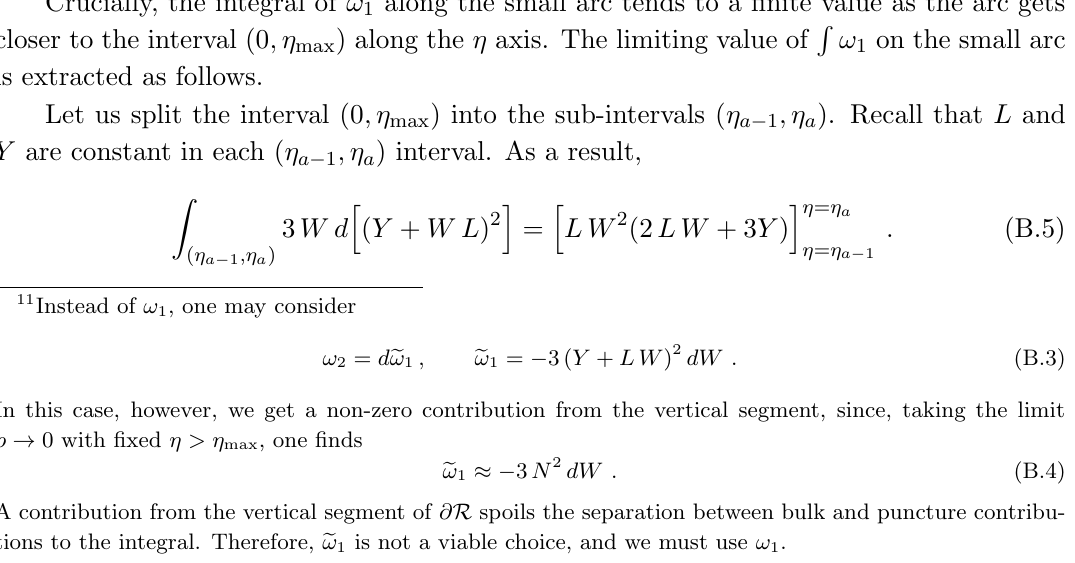
The region in the ( (cid:26); (cid:17) ) plane. We also depict the boundary @ R (counterclockwise)